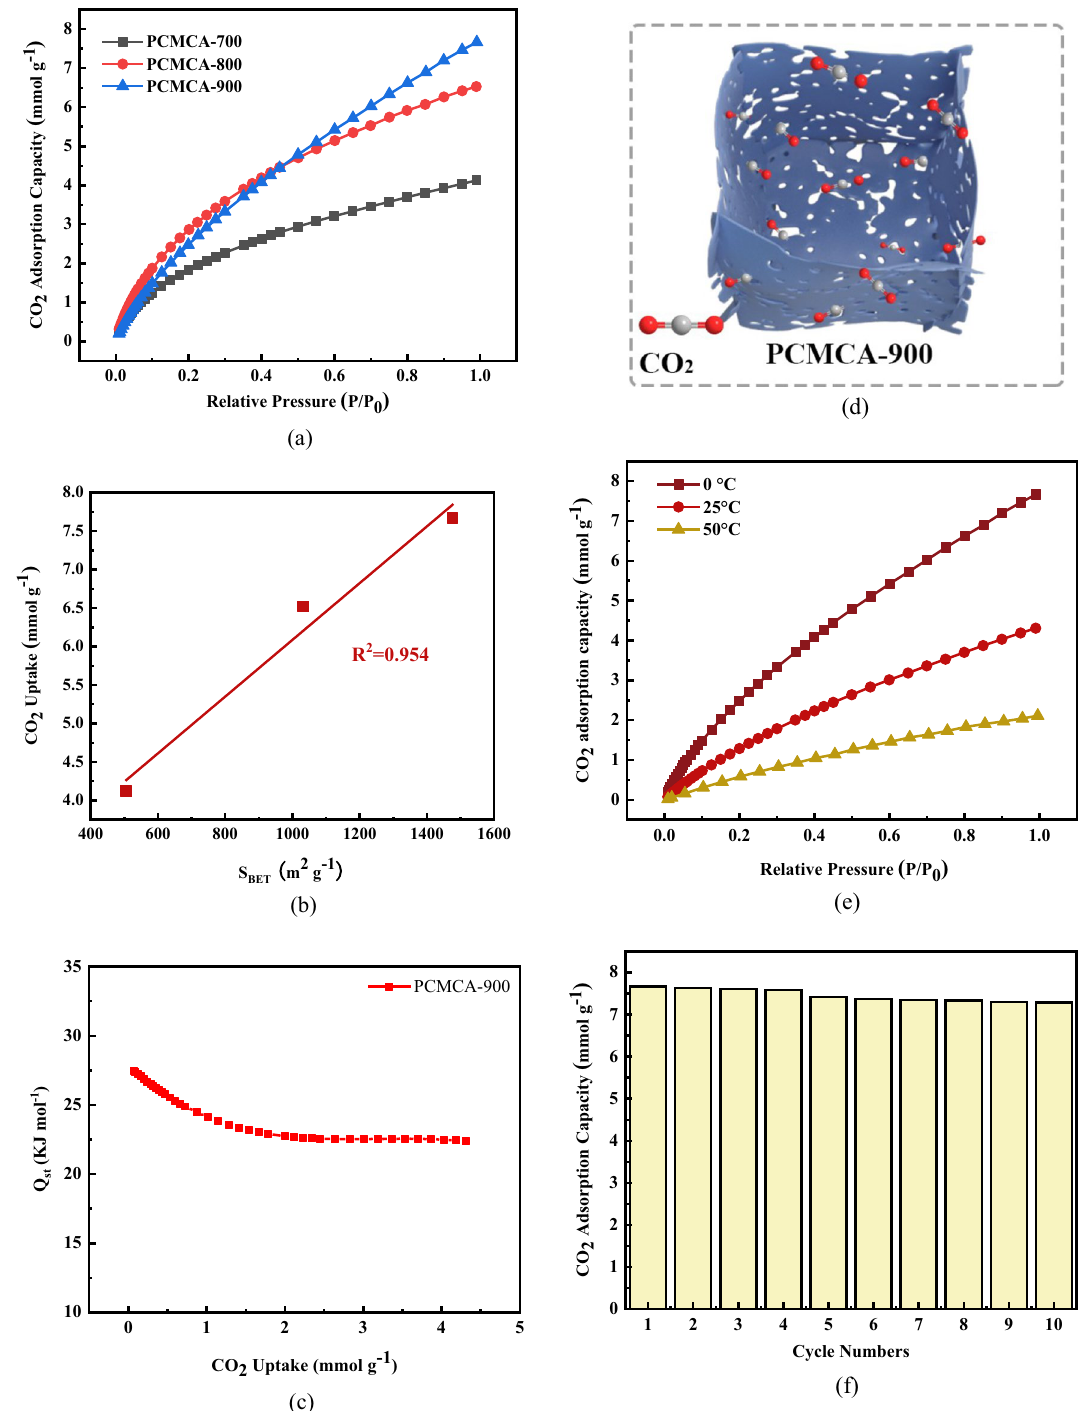
Fig. 4 a CO 2 adsorption isotherms and b S BET vs CO 2 uptake with a fitting line of PCMCA-X samples at 0 °C. c Q st of PCMCA-900. d CO 2 capture mechanism of PCMCA-900. e CO 2 uptake capacities at various temperatures (0 °C, 25 °C, and 50 °C) at 1 bar and f recyclability of